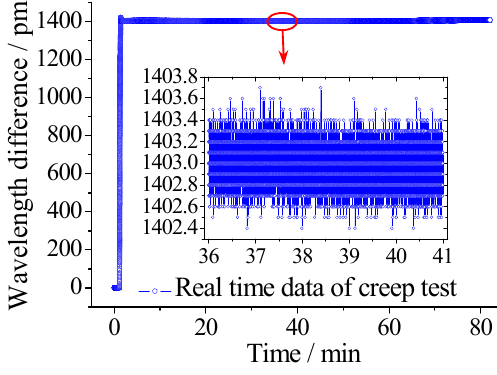
Figure 13. Result of creep performance test for displacement measurement.